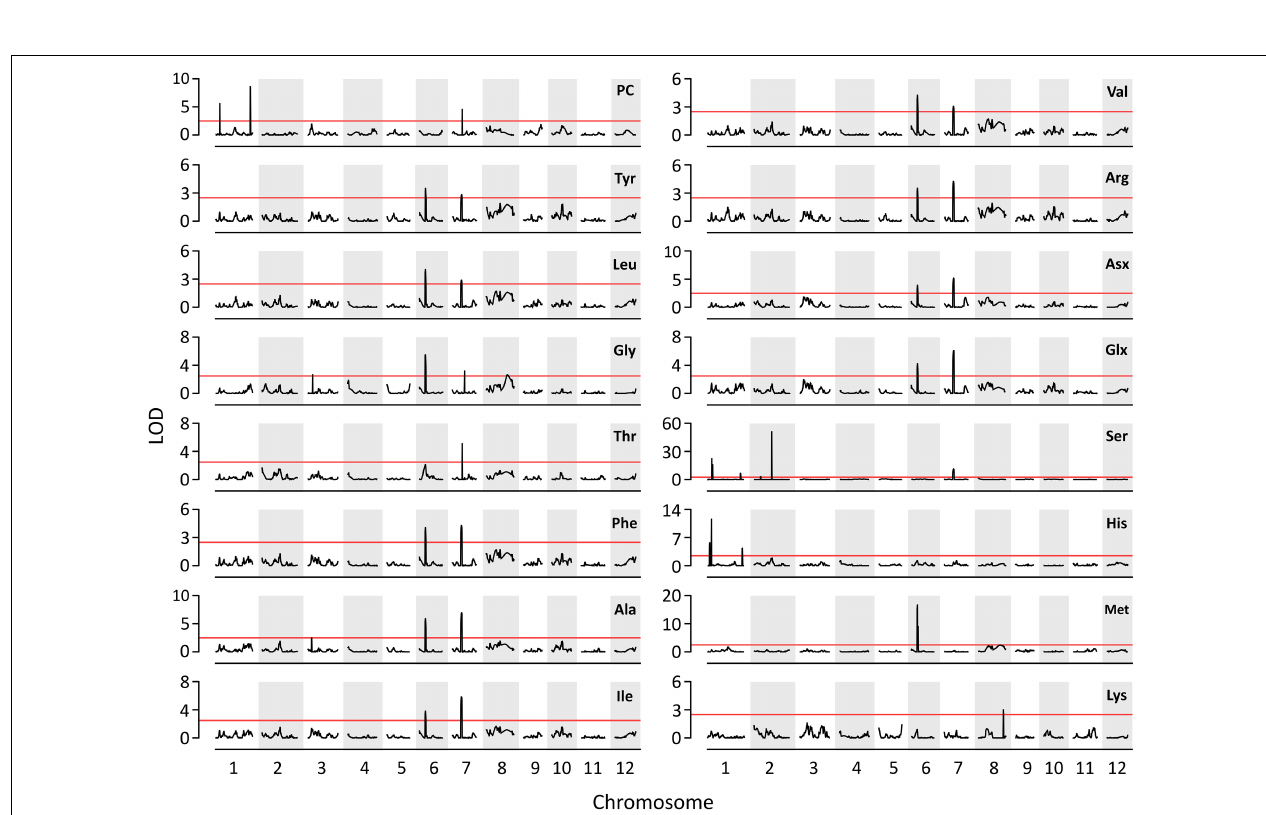
FIGURE 2 | The results of QTL analysis for AAC and PC. Red horizontal line indicates LOD threshold ( > 2.5).